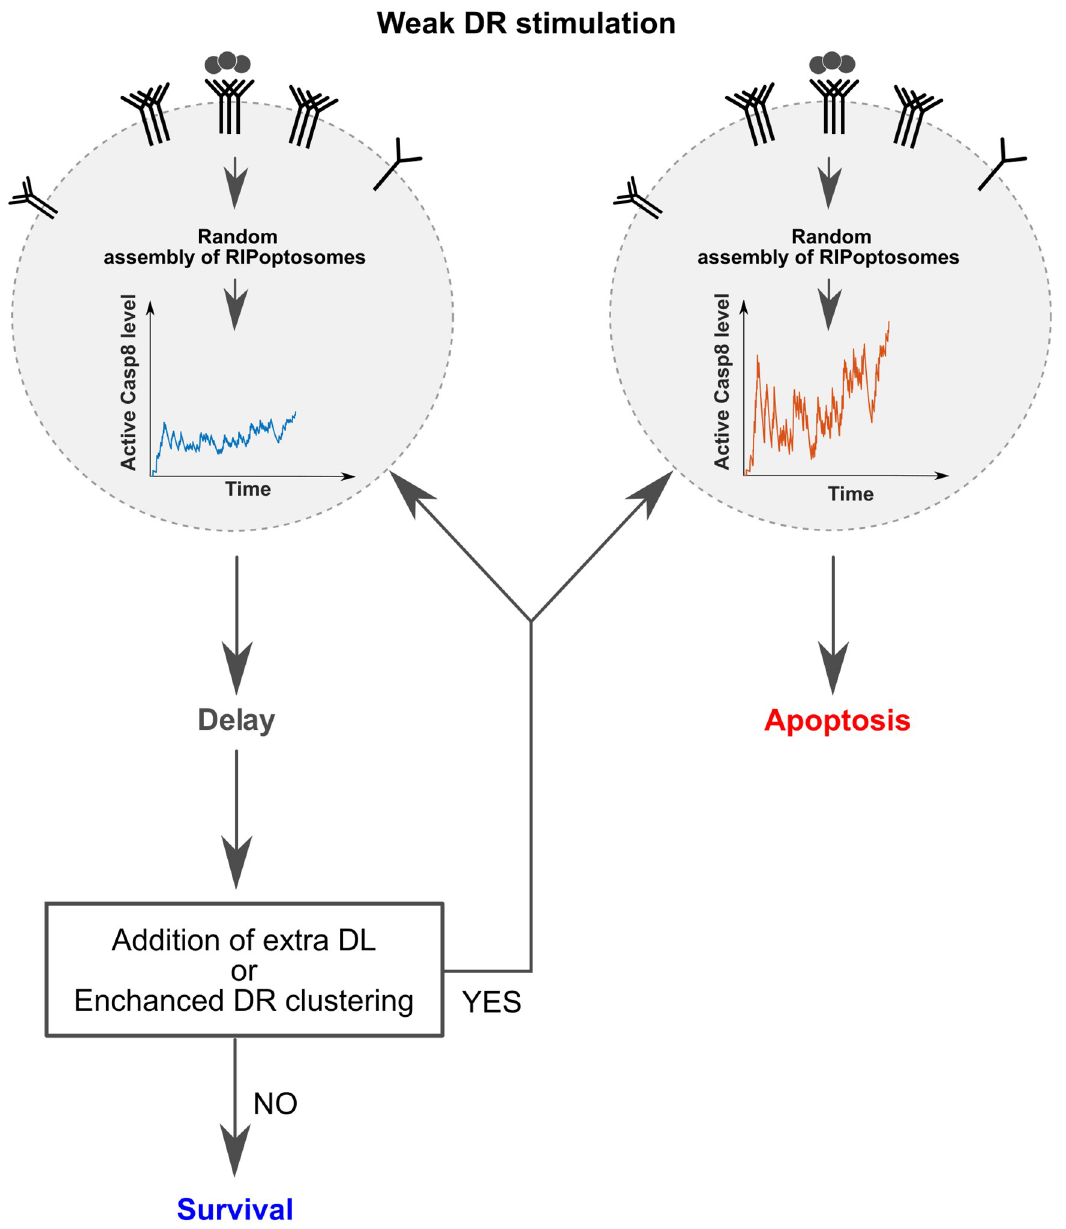
Fig 7. Representation of how stochastic assembly of the RIPoptosome yields kinetic proofreading of weak DR stimulation for individual cell. Figure represents two cell decisions. One of which, apoptosis, is taken because of the RIPoptosomes higher capacity to reconstitute Casp8 activation quicker and the signature of that is the high noise (red curve). The other decision is to wait or delay apoptotic cell response till more sophisticated DR signalling because the current RIPoptosomes are not efficient enough to maintain robust Casp8 activation rate which is confirmed by low noise (blue